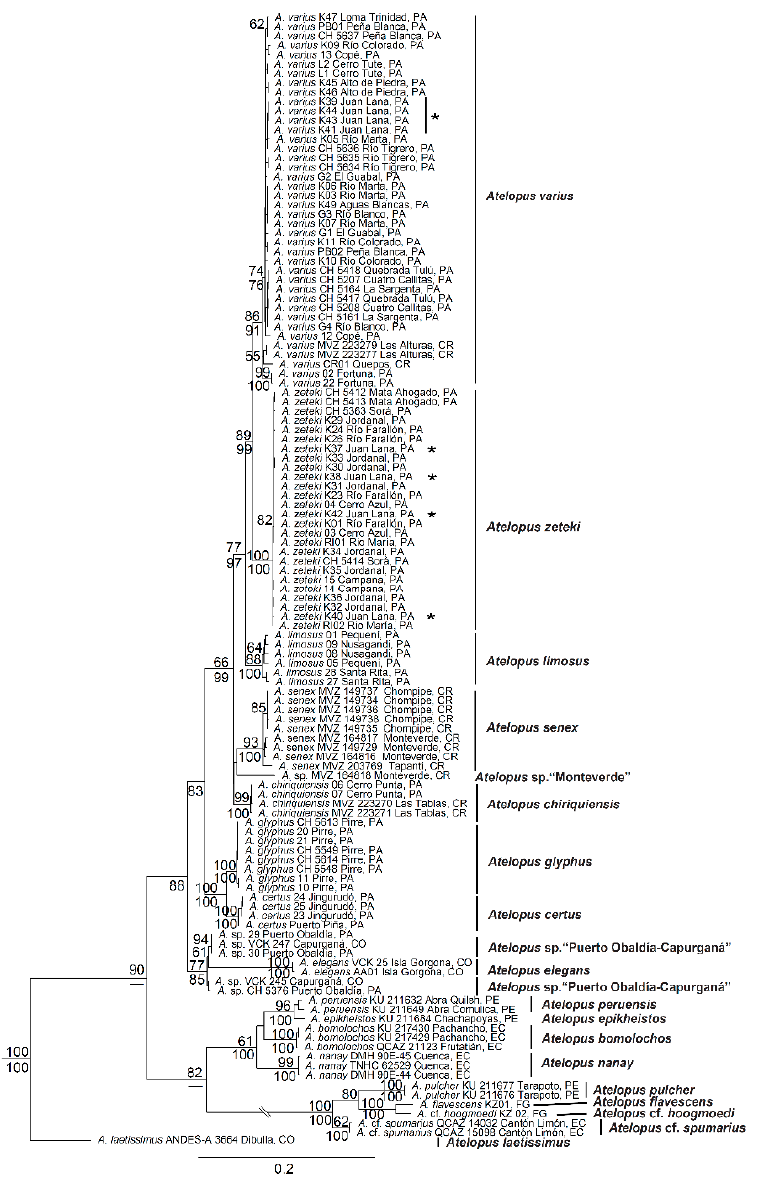
Figure 2. Maximum likelihood (ML) tree inferred from DNA sequences of two mitochondrial genes (COI and cyt b ) from the species of Atelopus of Central and South America. Outgroup samples consisting of non- Atelopus bufonids were removed for better visualization of the ingroup and are shown in Supplementary Figure S2. Branch support for all major clades is indicated as non-parametric bootstrap values under ML and maximum parsimony (MP) above and below each branch, respectively. However, to improve visualization of the tree, support values for only the earliest-diverging lineages of within-population samples are shown. A dash indicates MP bootstrap support below 50%. Specimens are indicated by their field or museum voucher number, or if not available, by the name of the locality where they were obtained. Specimens from the locality in which A. varius and A. zeteki are found in sympatry (Juan Lana, Panama) are marked with asterisks.